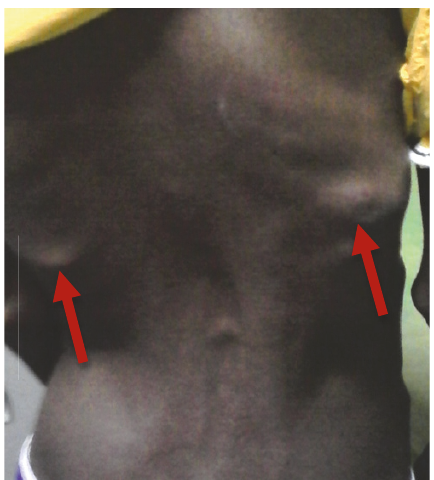
Figure 1: Bilateral back swelling (red arrows) with dextroconvex scoliotic lumbar attitude.